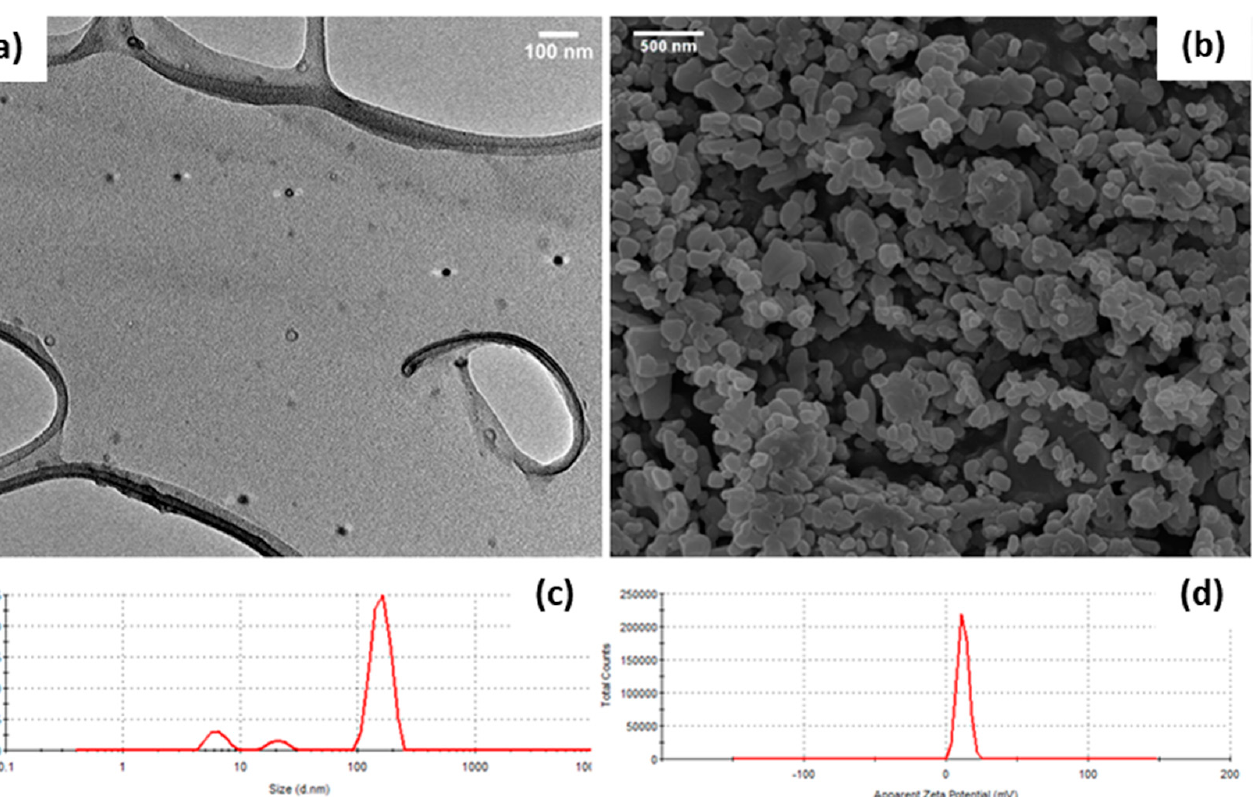
Figure 4. Size, shape and surface morphological characterization of LyP-1-functionalized ENT-loaded nanosystem. ( a ) TEM (60–120 kV) and ( b ) SEM (magnification: 25.00 kx) of the LyP-1-functionalized ENT-loaded nanosystem; ( c ) hydrodynamic particle size and ( d ) zeta potential (surface charge) of the LyP-1-functionalized ENT-loaded nanosystem.